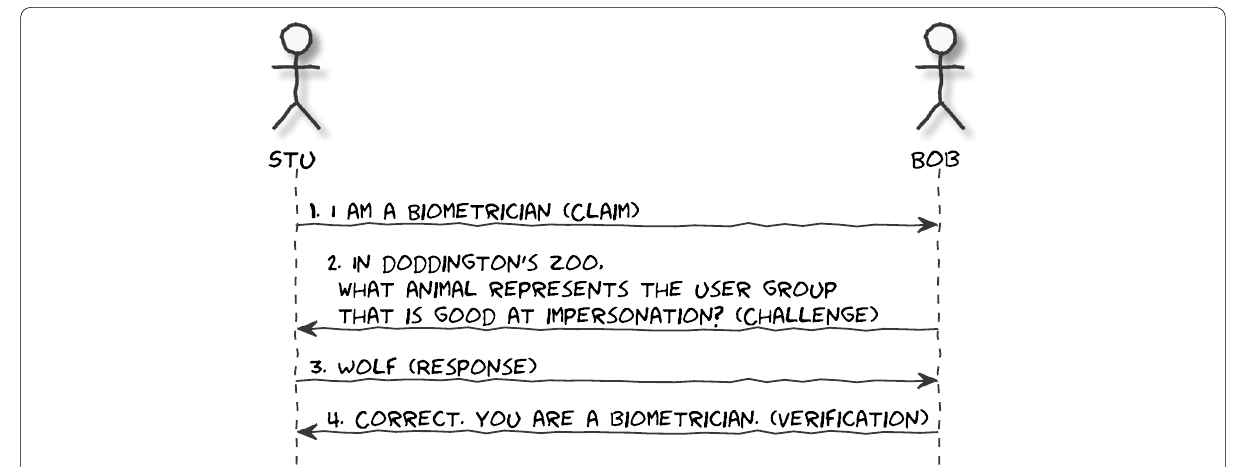
Fig. 2 Depicts a challenge-response protocol in the form of an interaction between a student Stu and a biometrician Bob. The claim is made in step 1, a challenge is issued in 2 and responded to in 3. Then, in 4, the authenticity of the initial claim has been verified, and Stu is thus a verified